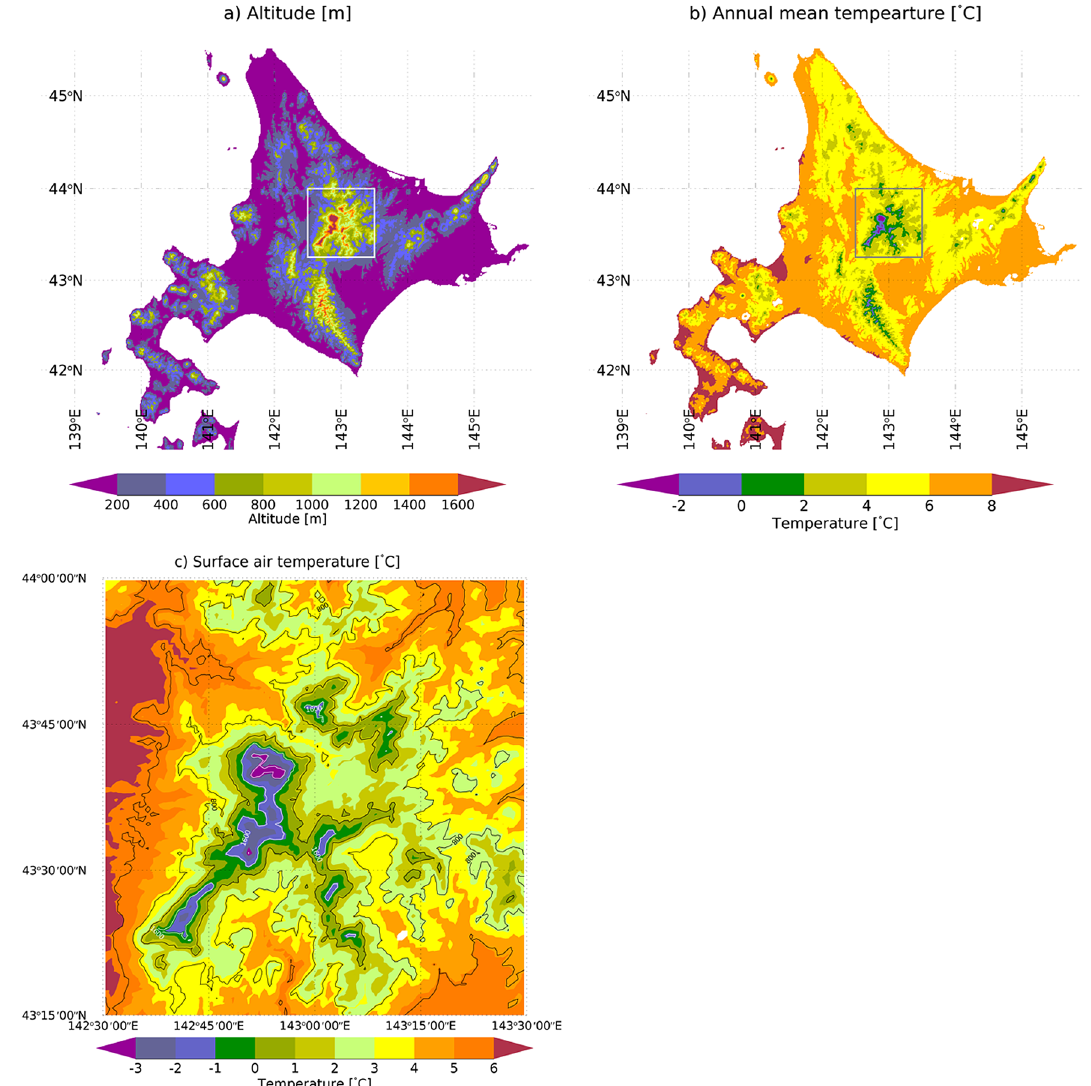
risge ospat ial. com/ Softw are- Techn ology/ IDL) is used to plot this